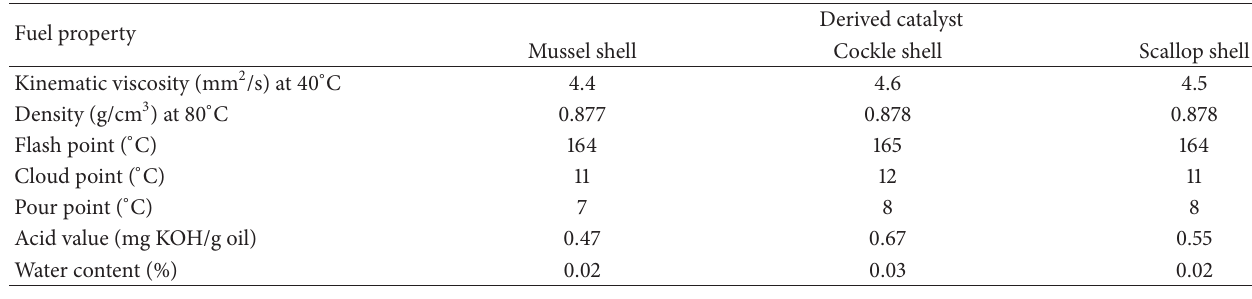
Table 3: The fuel properties of biodiesel.